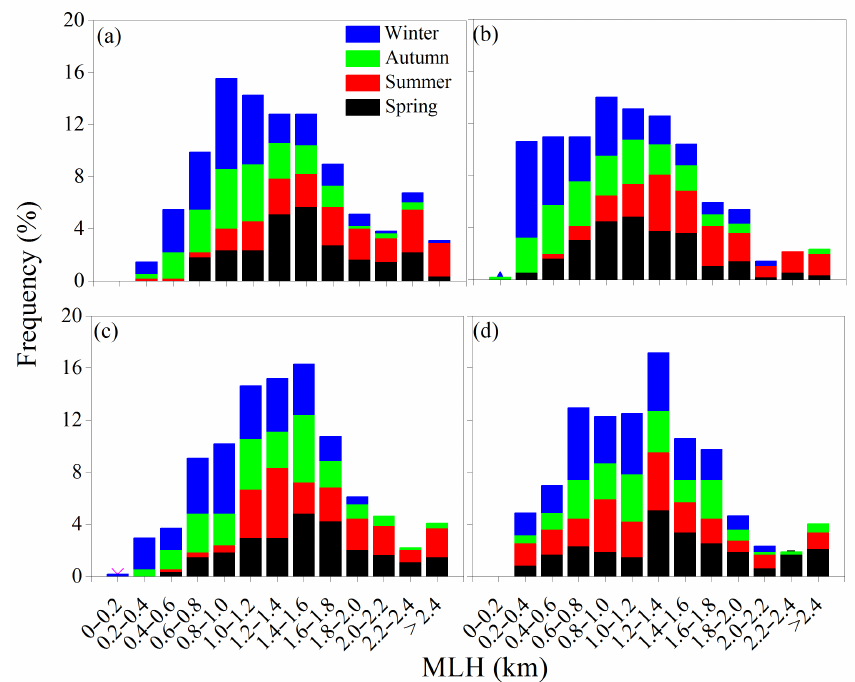
Figure 2. Frequency distribution of the daily maximum MLH at the (a) BJ, (b) SJZ, (c) TJ and (d) QHD stations from December 2013 to November 2014.